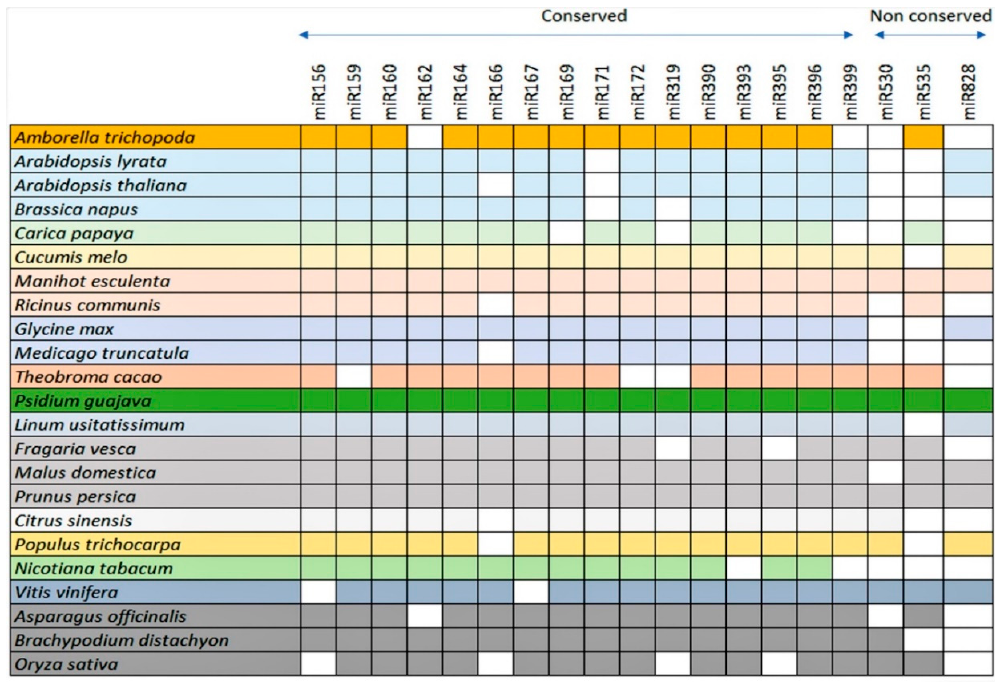
Figure 3. Conserved and nonconserved potential guava miRNA families (dark green boxes) and their homologs in other plant organisms. Identical color shades reflect closely related species, while filled and empty boxes indicate the presence or absence of miRNA families,